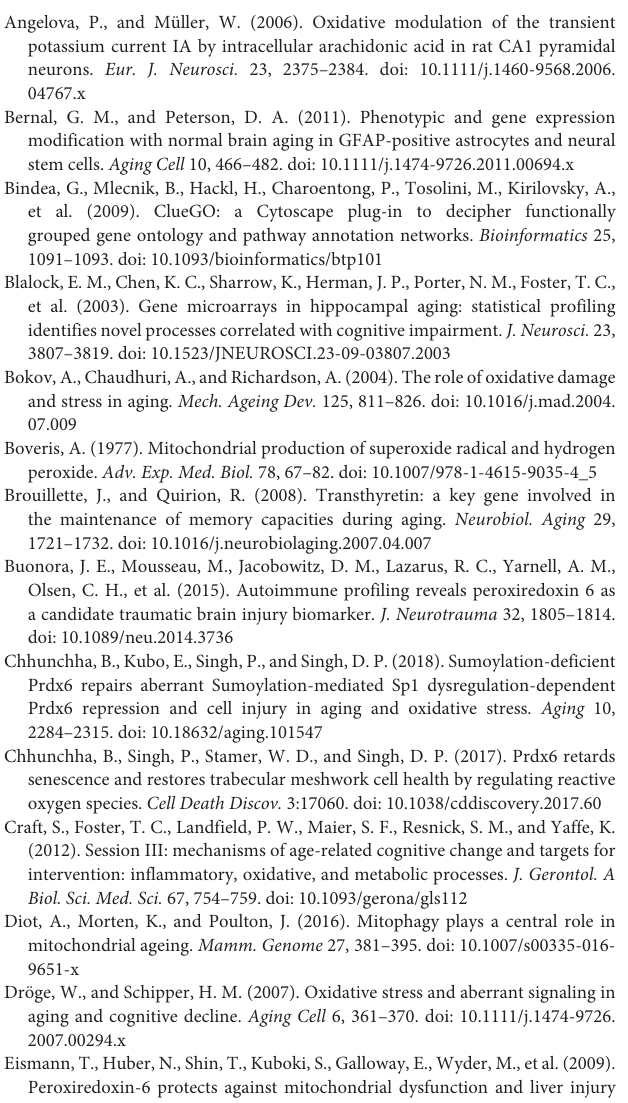
TABLE S1 | The list of proteins identified in the quantitative proteomic study and the proteins with significantly changed levels between young and aged unimpaired and aged impaired rats.